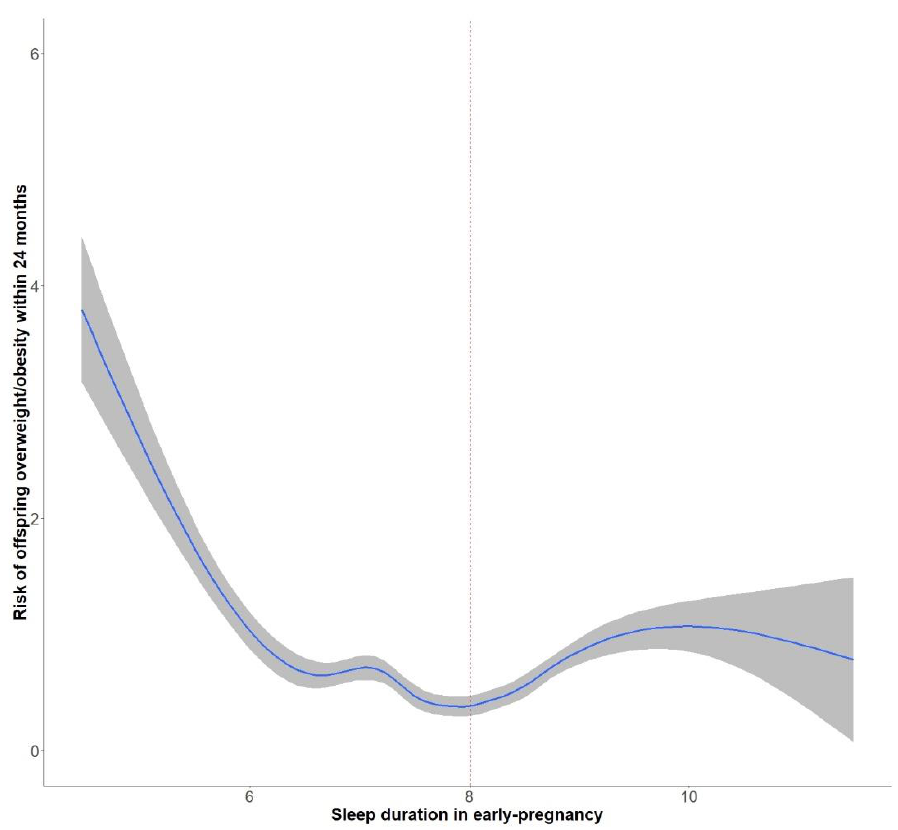
Figure 2. Effect of the maternal sleep pattern in early pregnancy and its change during pregnancy on physical growth of offspring within 24 months in the GDM subgroup [β/OR (95% CI)]. ( A ) Out- come is BAZ (BMI Z-score); ( B ) Outcome is catch-up growth; ( C ) Outcome is overweight/obesity; Green line: In the non-GDM population, the effect values for each group comparison; Red line: In the GDM population, the effect values for each group comparison; ** p < 0.01, * p < 0.05.